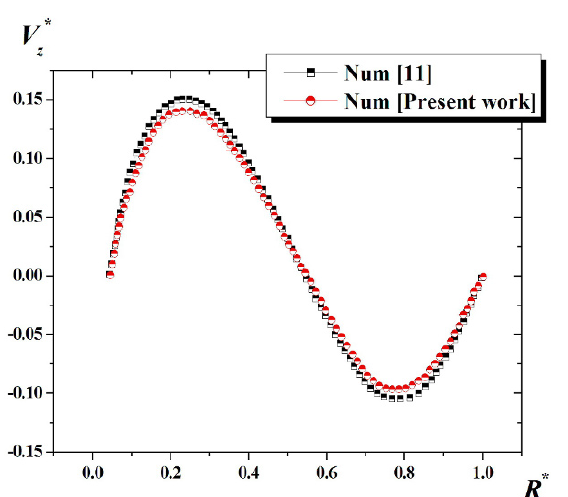
Figure 5. Power number for n = 0.4.